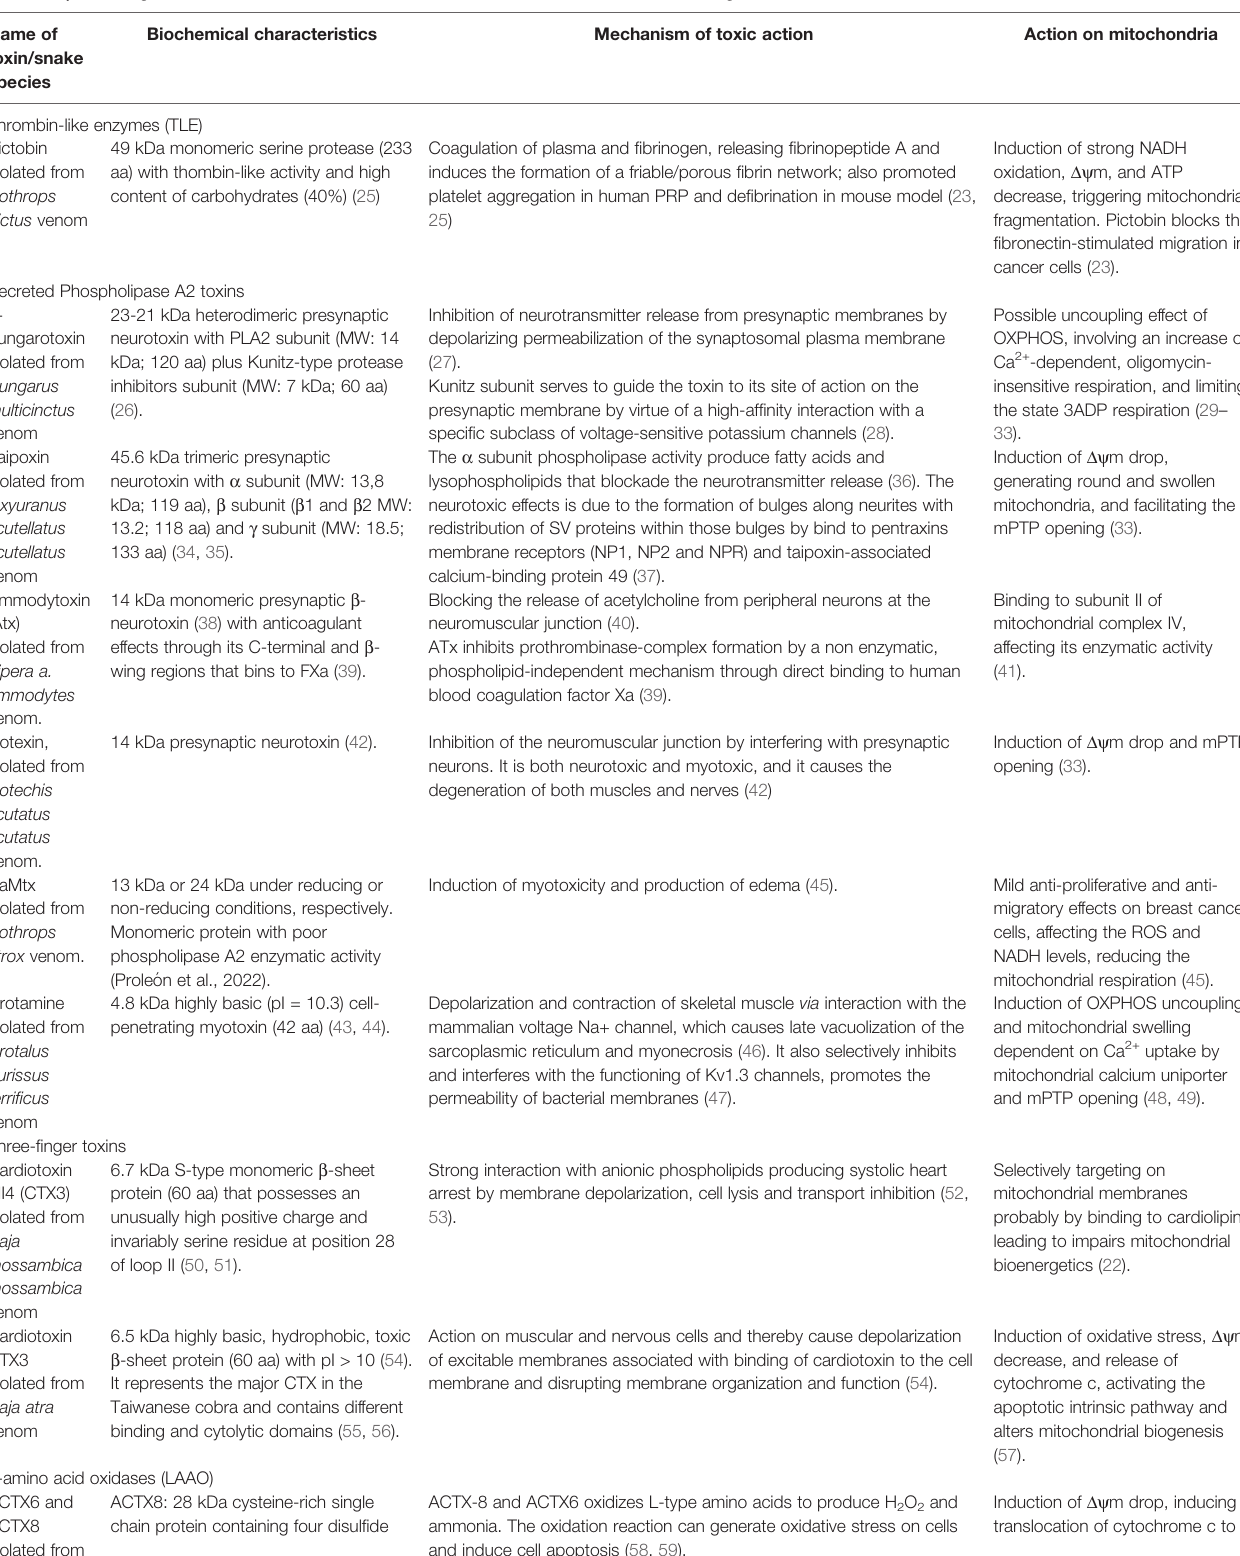
TABLE 1 | Toxicological mechanisms of snake venom toxins with effects on mitochondrial bioenergetics of cancer cells. Name of